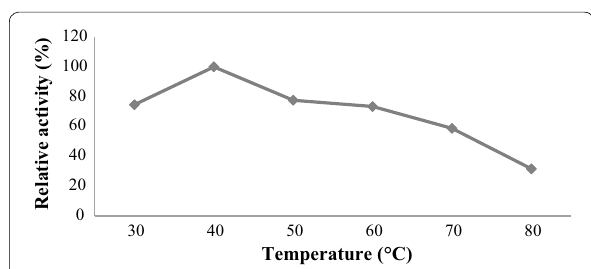
Fig. 7 Effect of temperature on keratinase activity. Enzymatic reac- tion was carried out at temperatures from 30 to 80 °C for 10 min in shaking water bath and results are presented on graph. Data repre- sent the means of